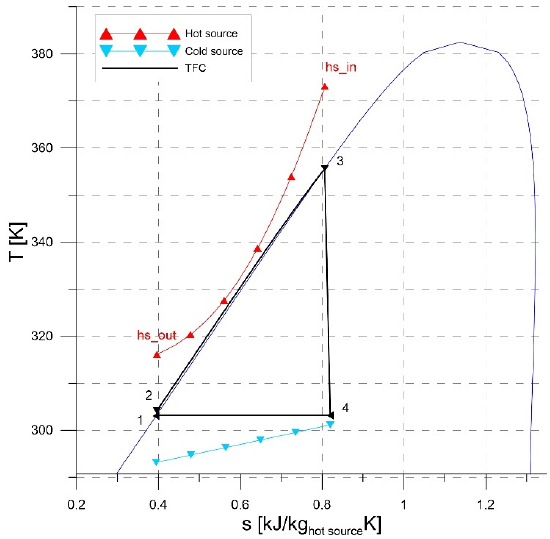
Figure 8. TFC T-S diagram [152]: transformation 1–2 is a pressurization in the liquid phase, 2–3 heating of the liquid, 3–4 is the wet expansion, 4–1 the condensation. Dark blue line is the saturation curve of the working fl uid (R1234ze(E)).